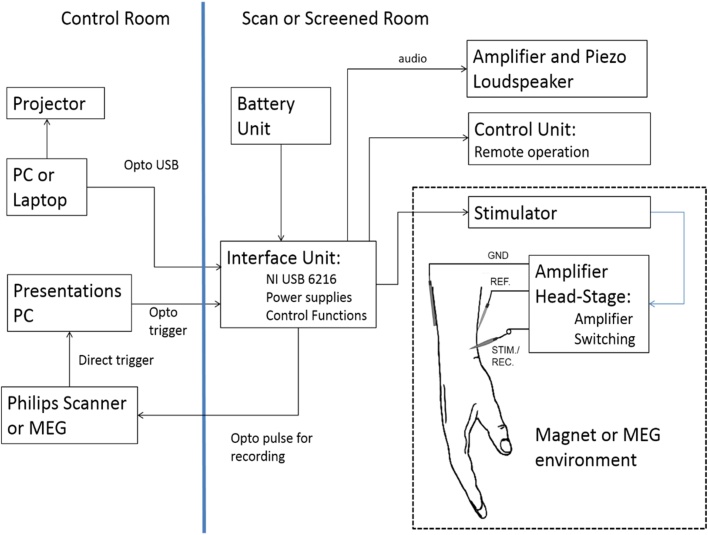
INMS system diagram.All equipment within the screened room is optically isolated for participant safety. Only the stimulator and head-stage units are approved for use within the bore of the 7 T magnet. The piezo loudspeaker and remote control unit are non-magnetic and can be used near the magnet during participant preparation. The interface unit and battery, whilst not projectile hazards, are not designed to work in high magnetic fields, and are situated at the edge of the screened room area. A similar set-up is employed within the MEG suite. The audio channel may, if preferred, be taken from the host control computer and played through speakers placed at the doors of the scan room.